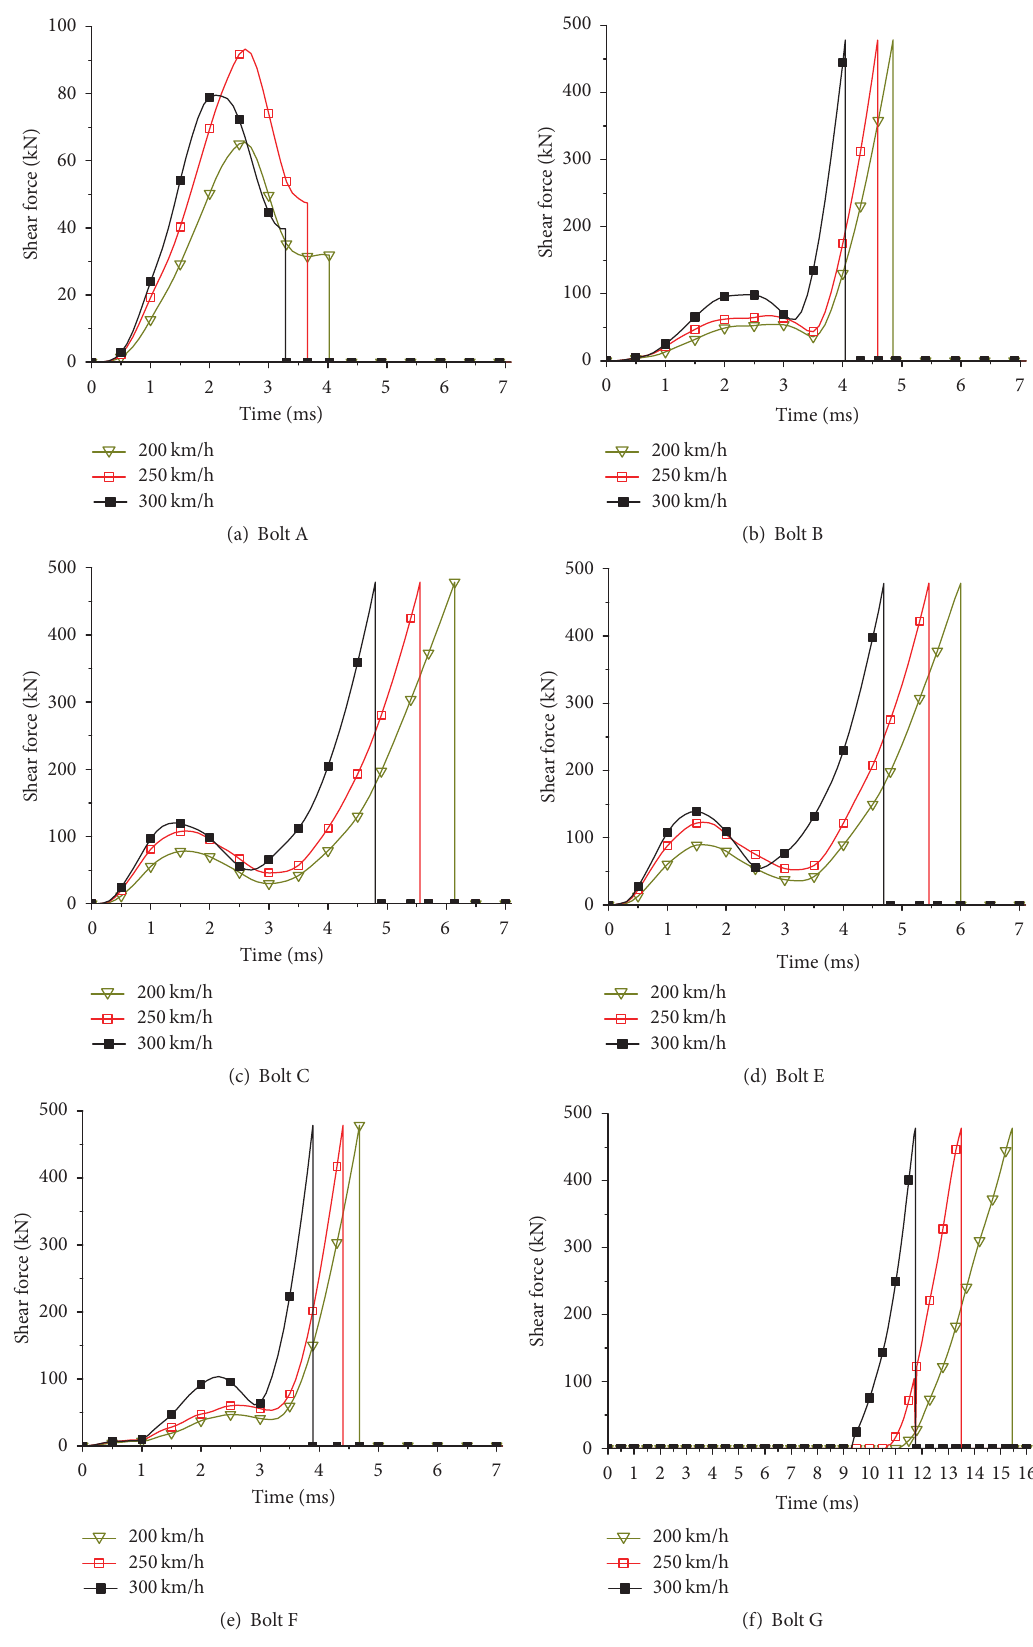
Figure 22: The Shear force time history curves for bolts A, B, C, E, F, and